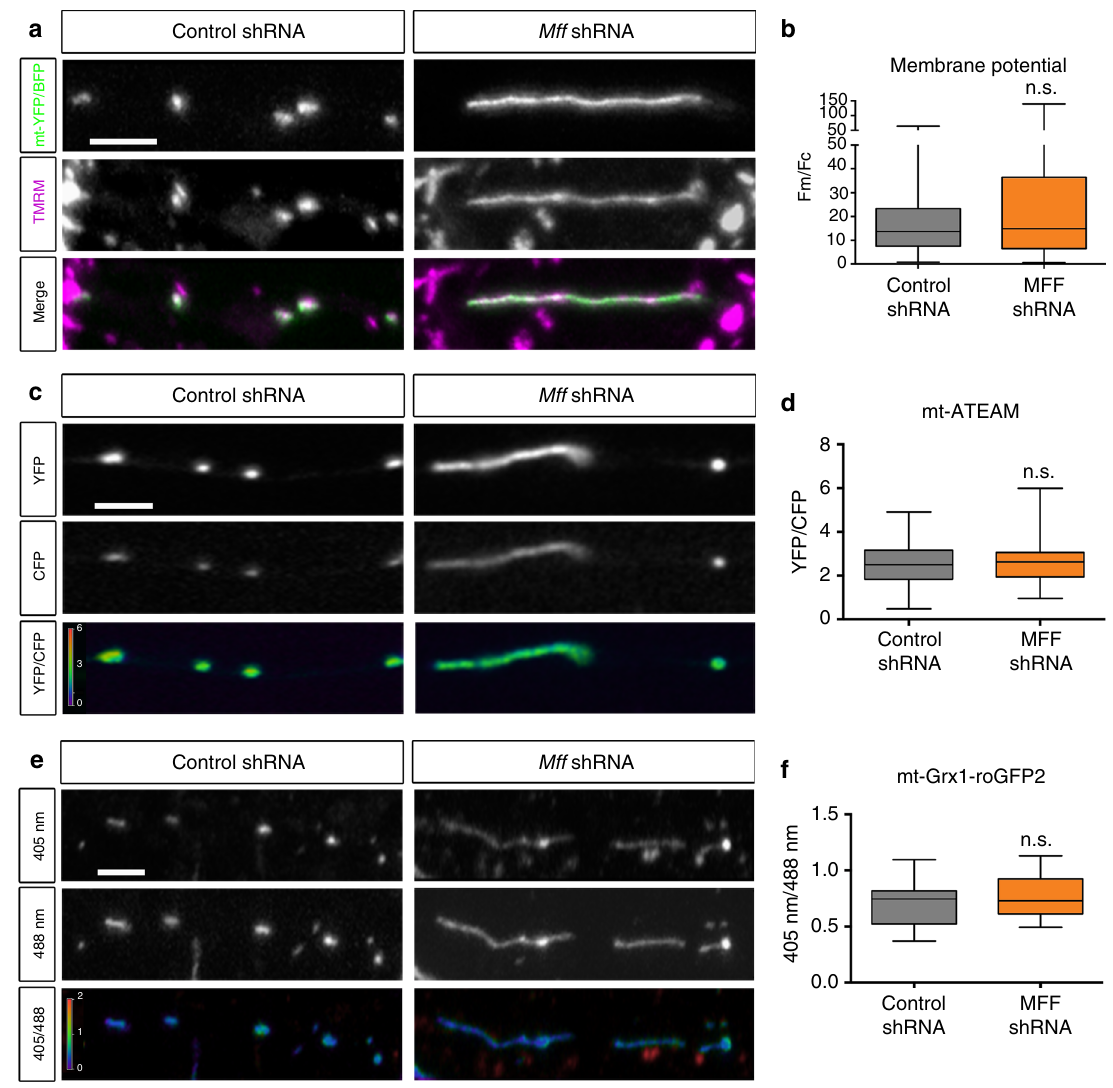
Fig. 5 Loss of MFF does not signi fi cantly alter mitochondrial membrane potential, mitochondrial ATP levels or the redox potential of the mitochondrial matrix. a Representative images from axons of neurons electroporated with mt-mTAGBFP2, Venus (cell fi ller) and control shRNA (left panels) or mt-YFP, mTAGBFP2 (cell fi ller) and a 1:1 mixture of Mff shRNA (539:665) (right panels) via EUE at E15.5, and treated with 10 nM TMRM at 7DIV. b Quanti fi cation of (( F mitochondria / F cytoplasm )/(Mitochondrial Area)) for TMRM at 7DIV. Data is represented as minimum to maximum box plots, with the box denoting